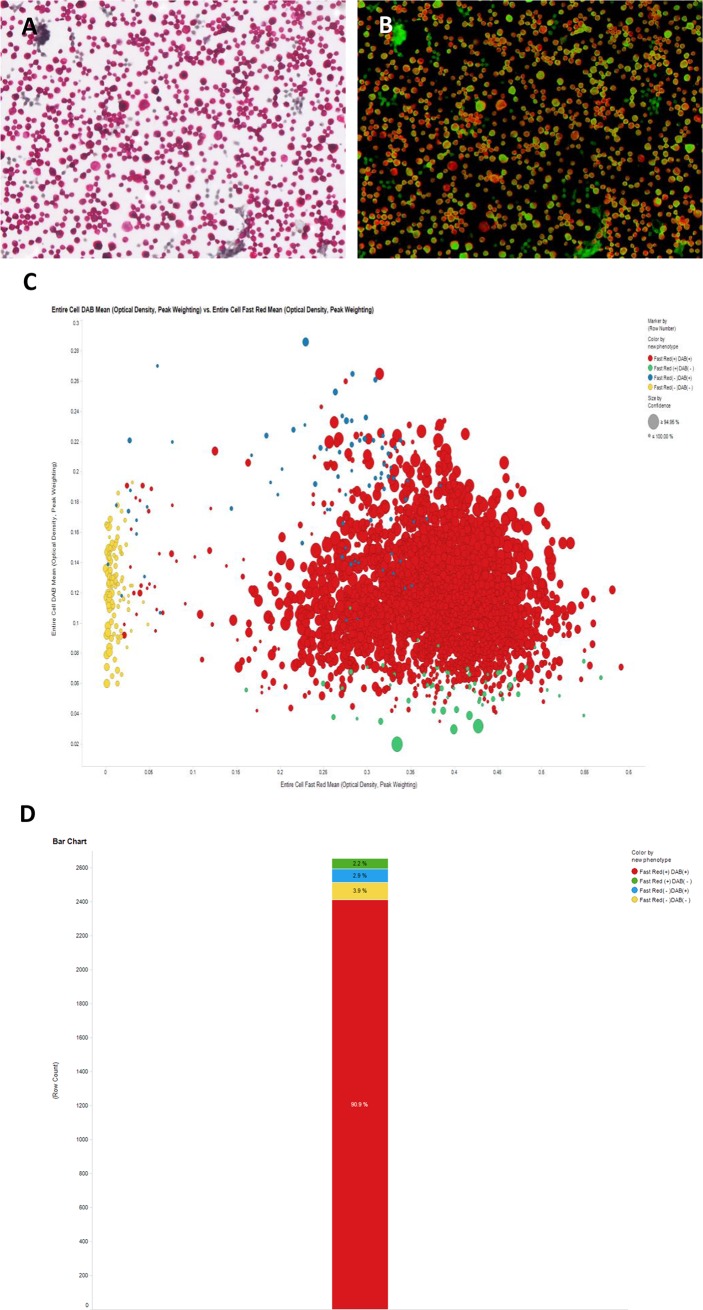
Automatic digitalized interpretation of dual immunocytochemistry.In most cases of ovarian cancer, cells with the typical dual staining (CK7+/PAX8+) pattern represented over 90% of the cell population.